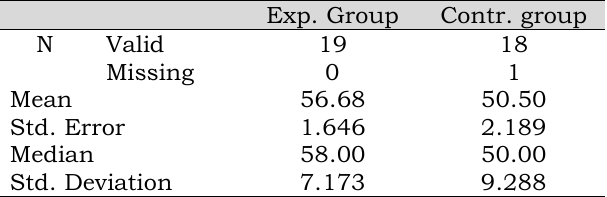
Table 1. Descriptive statistics of posttest